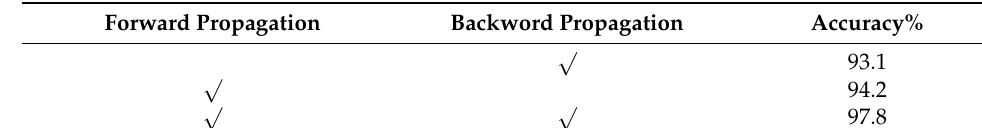
Table 11. The ablation results with formation energy, thermodynamic threshold, crystal structure volume, and oxygen vacancy.